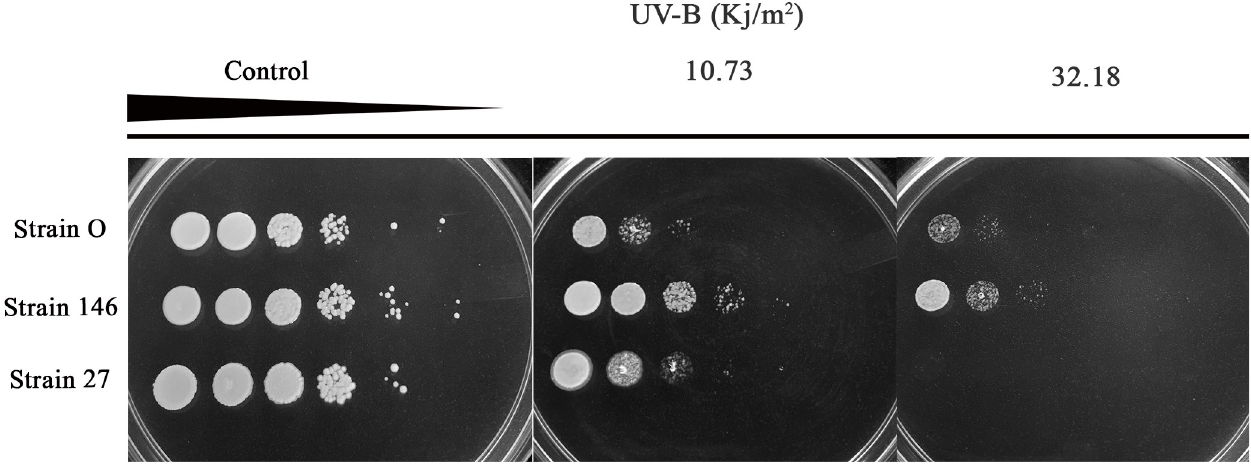
Fig 4. Growth assessment after UV-B irradiation of yeasts cells exposed to different dosages. Cells were ten-fold serially diluted, and 5 μ L of each dilution was spotted onto YEPD agar. Subsequently, the plates were irradiated with UV-B at the indicated doses: 5.36 Kj/m 2 (0.5 h), 10.73 Kj/m 2 (1 h), 16.09 Kj/m 2 (1.5 h), 21.46 Kj/m 2 (2 h), 26.82 Kj/m 2 (2.5 h) and 32.18 Kj/m 2 (3 h). The figure exemplarily shows the control, without any exposure to UV-B, and those that been exposed for 1 h (10.73 Kj/m 2 ) and 3 h (32.18 Kj/m 2 ),